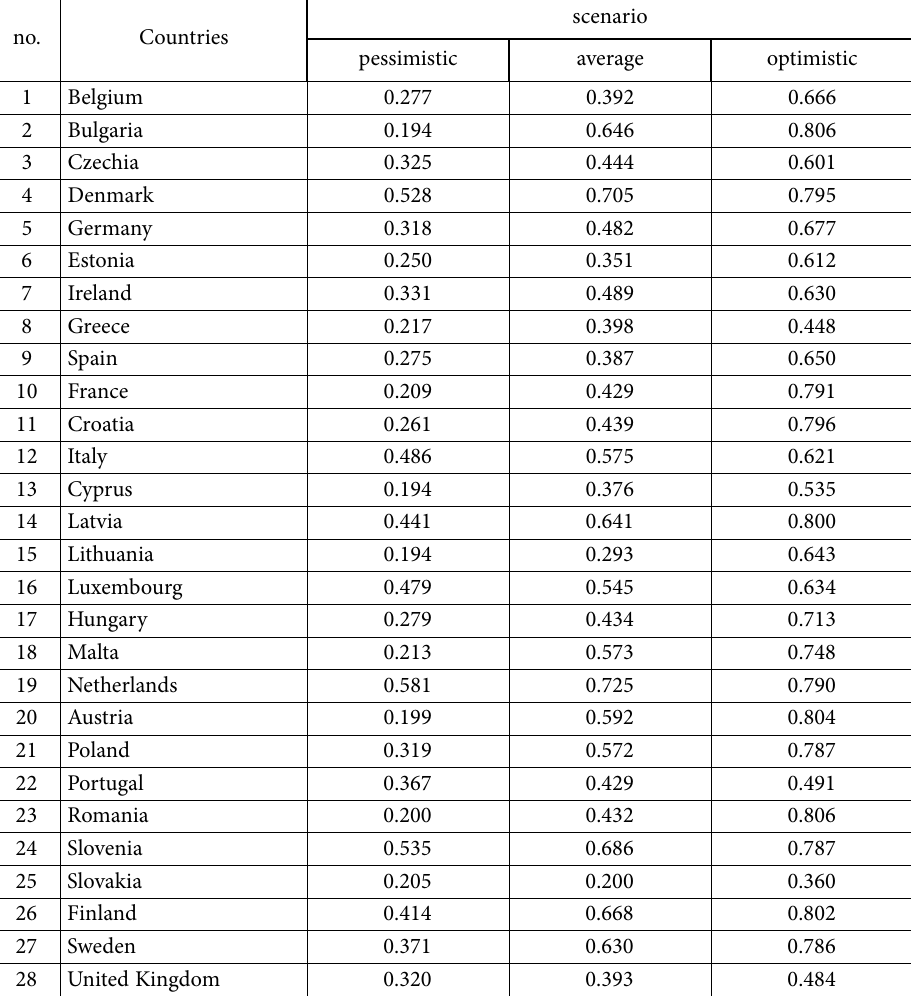
Table 4. The values of the synthetic measure for the pessimistic, average, and optimistic scenarios